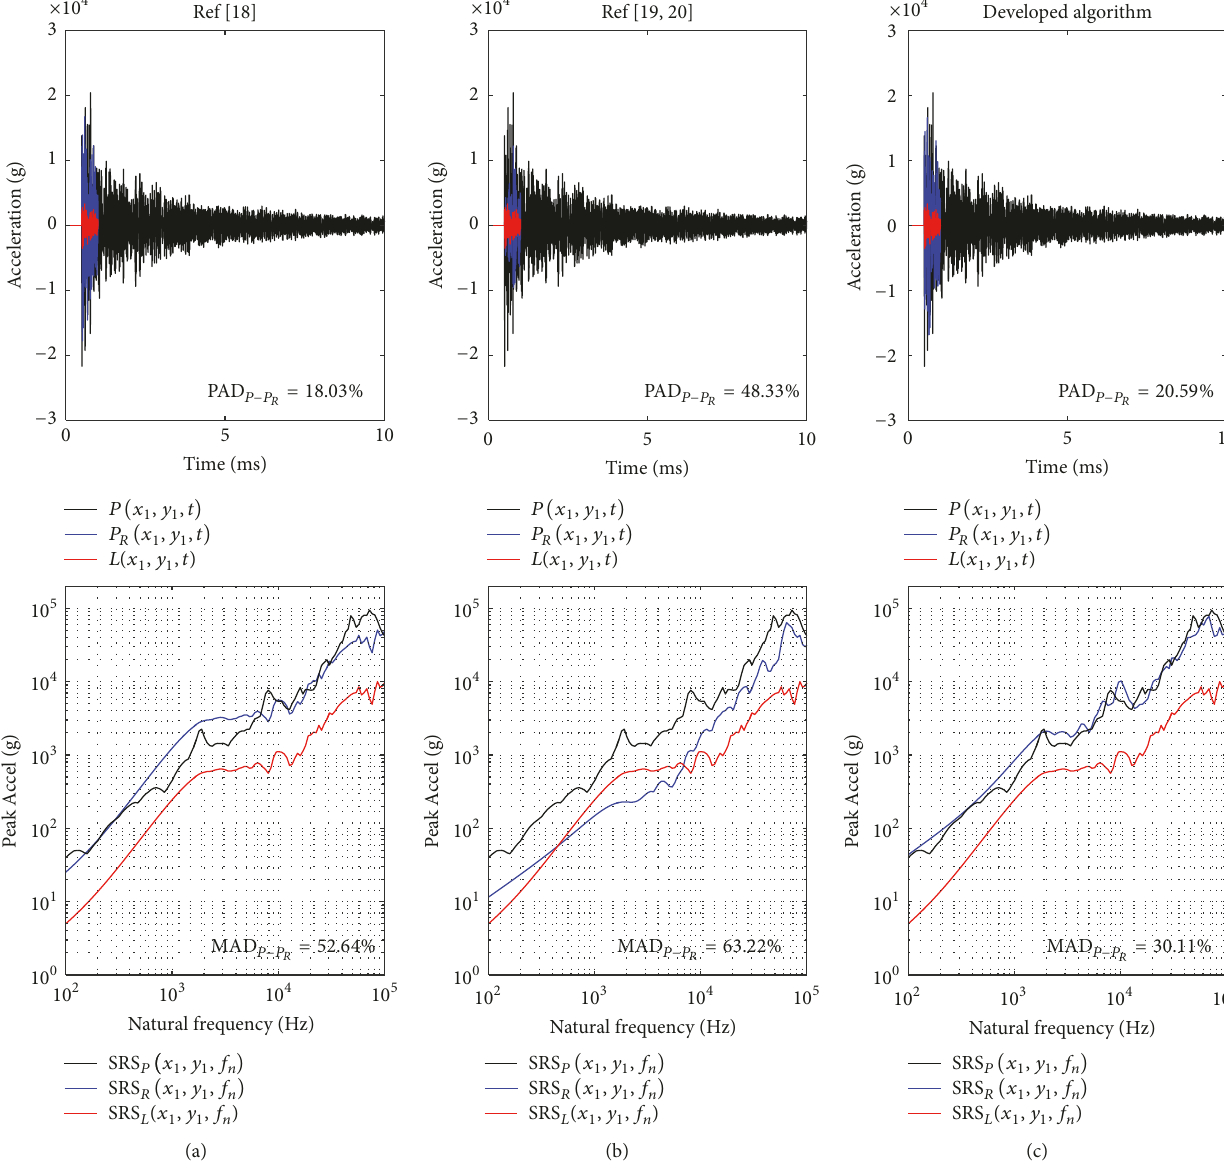
Figure 26: Comparison of reconstruction results of pyroshock on the disk type specimen at the verification point. (a) Ref [18]. (b) Ref [19, 20]. (c) The algorithm proposed in this